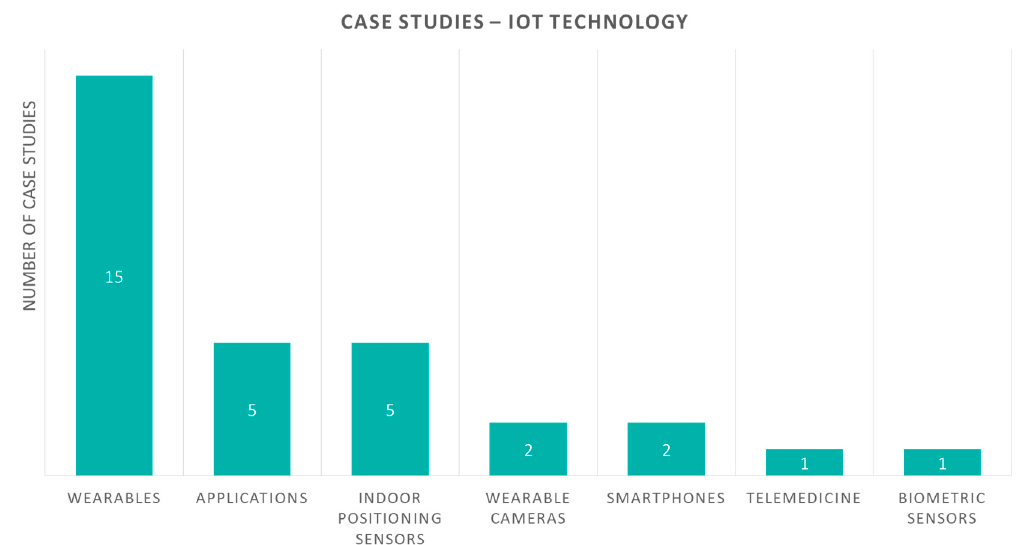
Figure 7. Case study papers according to the IoT devices used.